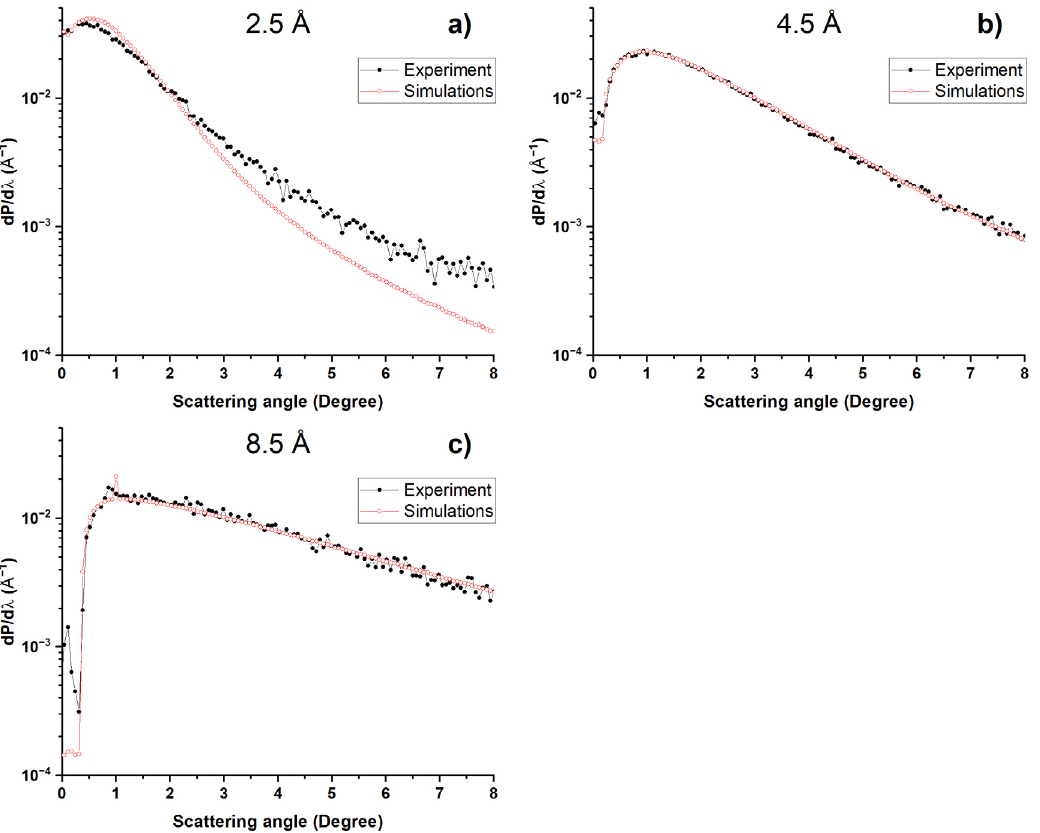
Figure 10. Simulated and measured angular distributions of QSR neutrons for the F-DND sample at three wavelengths: ( a ) 2.5 Å, ( b ) 4.5 Å and ( c ) 8.5 Å. In all cases, the angle of incidence was 1°.